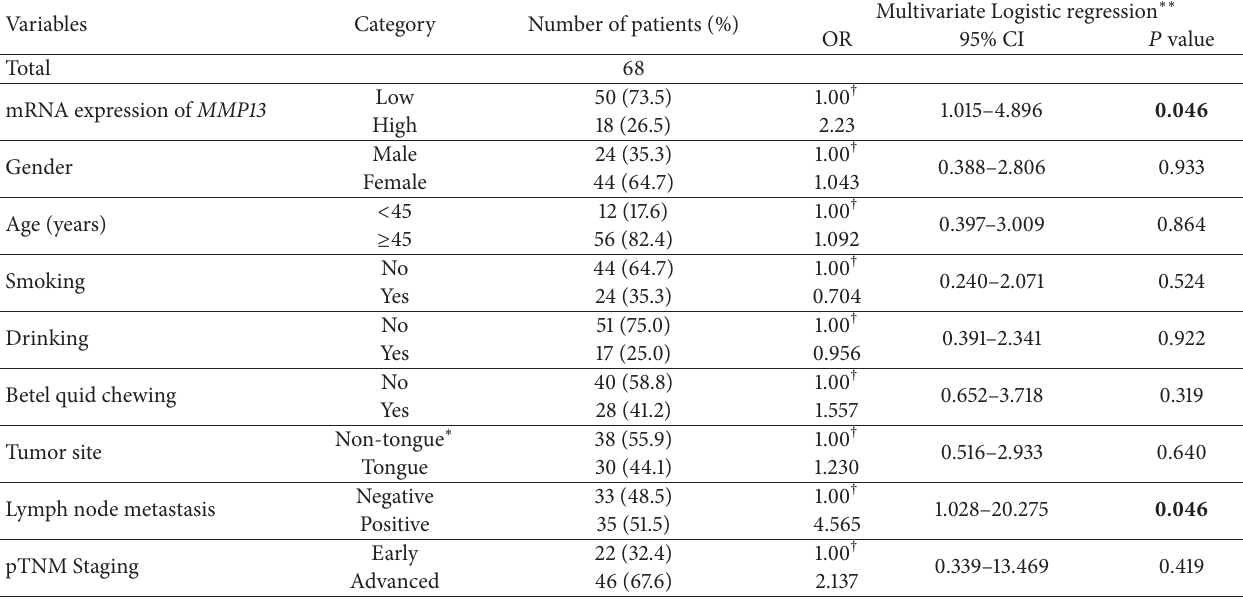
Table 3: Multivariate cox regression model analysis of MMP13 mRNA expression in OSCC overall